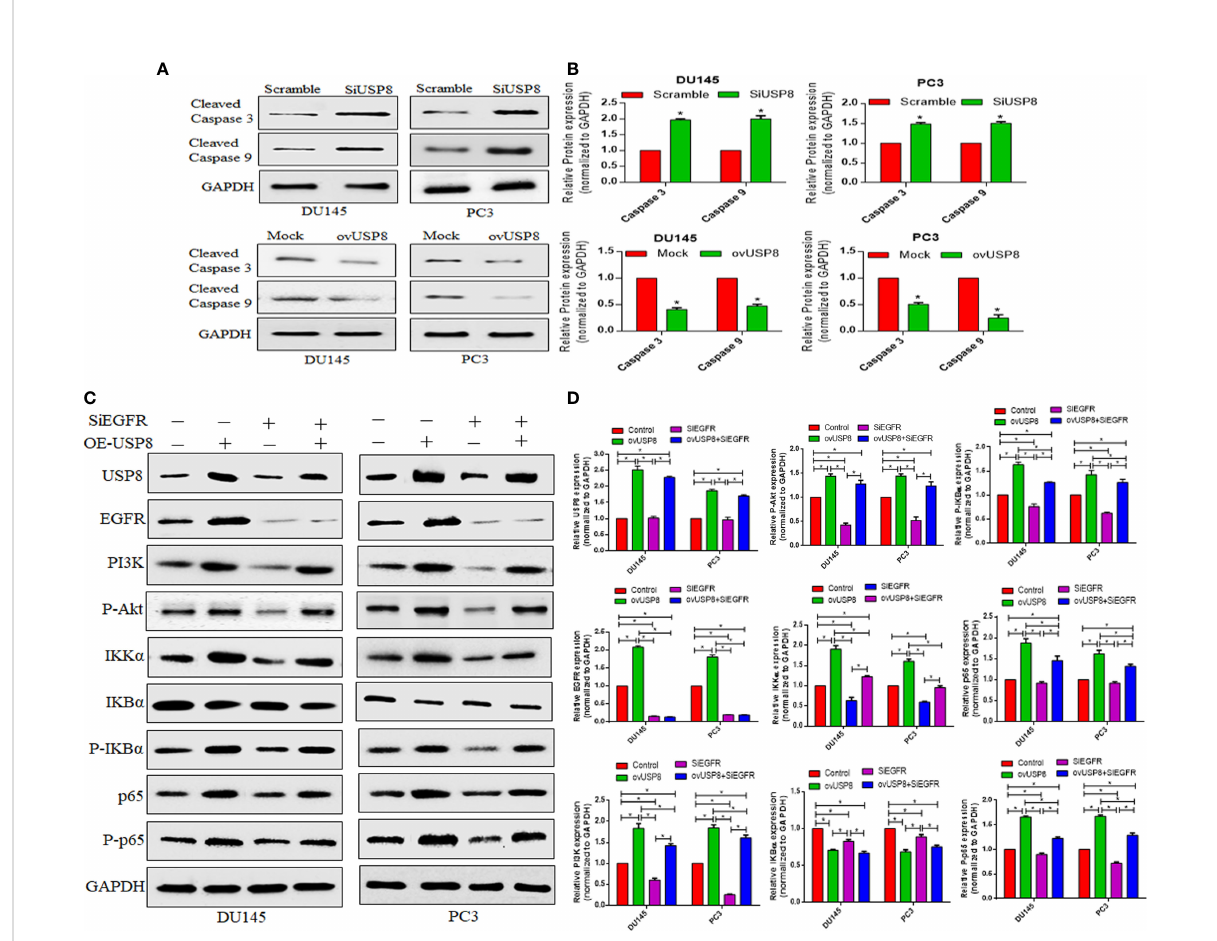
FIGURE 6 USP8 regulates pro-apoptotic proteins and upregulates the NF- k B pathway through EGFR and PI3K in PCa cells. (A) The DU145 and PC3 cells were transfected with SiUSP8 and pCMV3-USP8-overexpressing vector for 48 h. Western blotting was conducted after total protein extraction. The indicated antibodies (cleaved caspase 3 and cleaved caspase 9) were used to observe their expression. The GAPDH was utilized as a control in Western blotting. (B) The relative gray value was measured using ImageJ software and plotted on a bar diagram by GraphPad Prism. The data were standardized using GAPDH as a loading control and given as mean ± SD (n = 3, * p <0.05). (C) The DU145 and PC3 cells were treated with USP8 overexpressing plasmid and SiEGFR individually or combinedly, and for Western blotting, complete protein was obtained. Antibodies to the indicated proteins (USP8, EGFR, PI3K, IKK a , IKB a , P-IKB a , p65, P-p65) were used to detect their expression. As a control, GAPDH was employed. (D) ImageJ was used to compute the relative gray value of the blots. The results were standardized using GAPDH as a loading control (individual protein/GAPDH) and shown as mean ± SD from three replicated experiments (n = 3, * p <